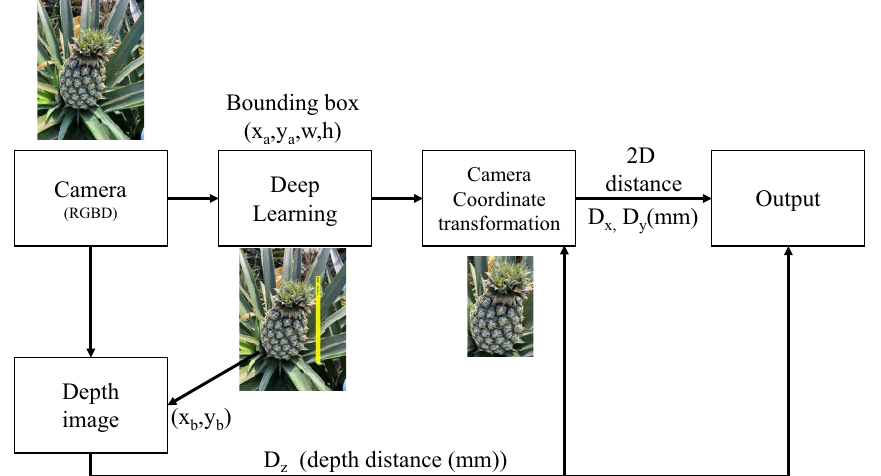
Figure 5. System